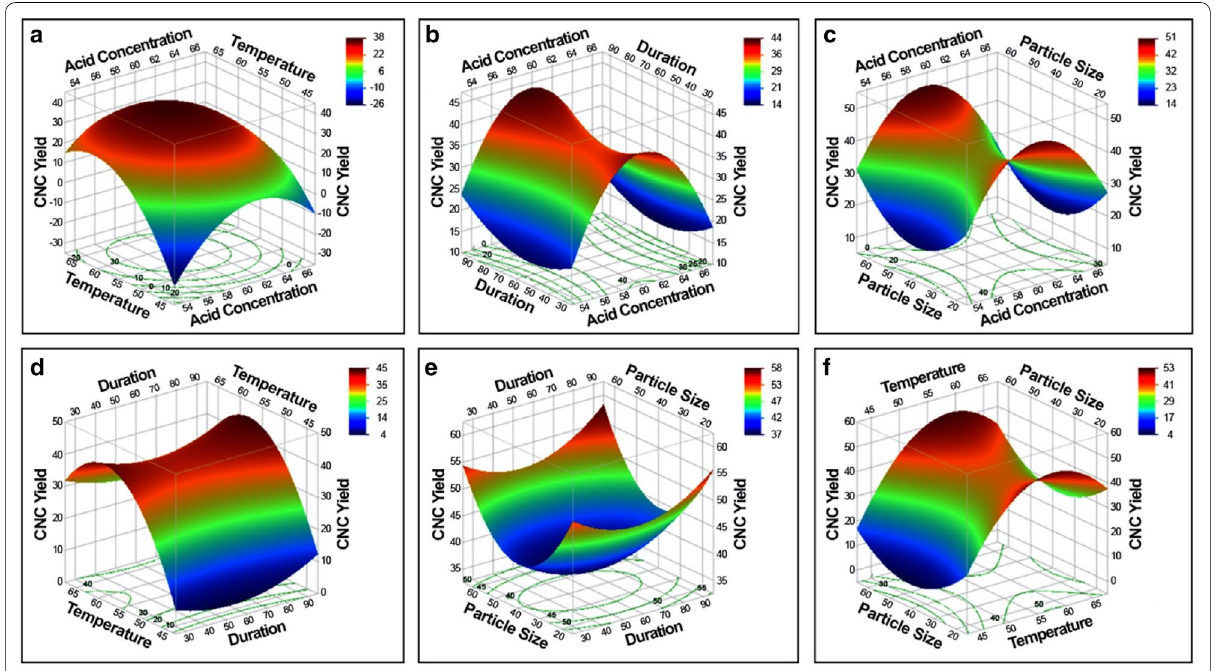
Fig. 3 Response surface and contour plots showing interaction effects of different process parameters on CNC yield: a acid concentration temperature; b acid concentration hydrolysis duration, and f particle size